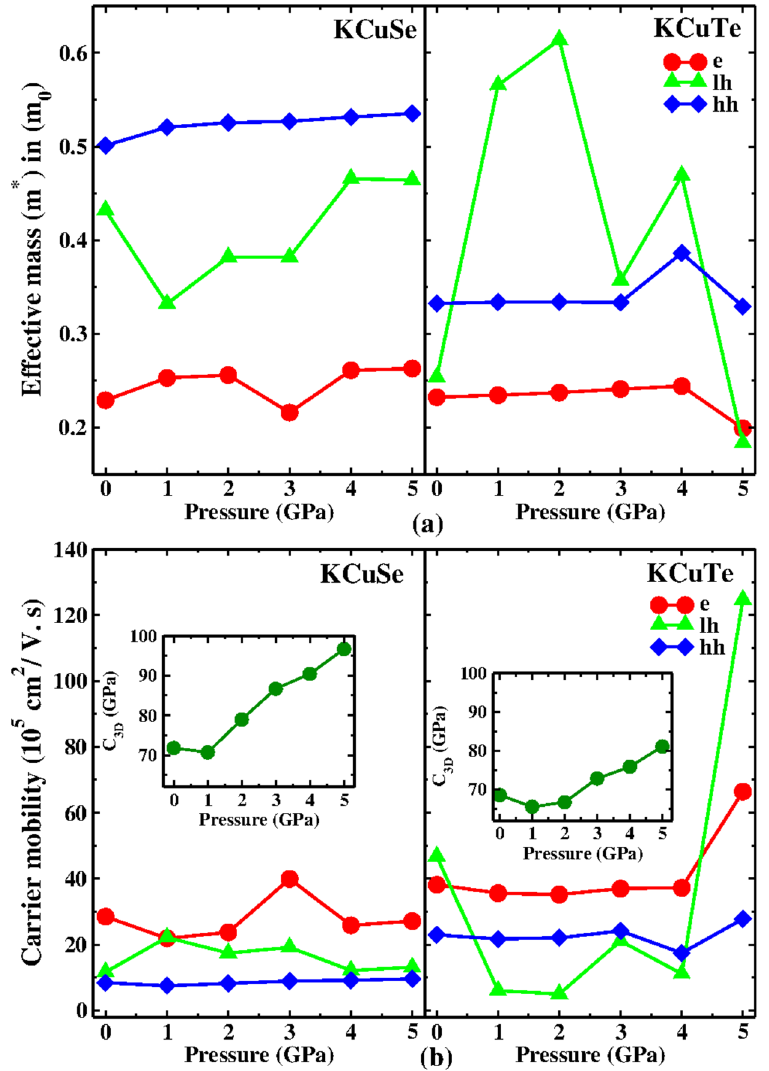
Figure 8. Effect of pressure (0–5 GPa) on ( a ) Effective mass ( m * in m 0 ) and ( b ) Carrier mobility and elastic modulus (inset) for KCuX(X = Se,